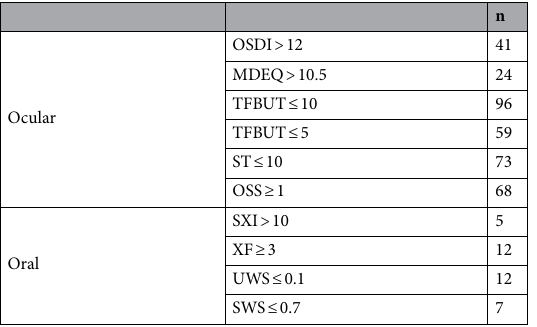
Table 3. Number of subjects with pathological levels of ocular and oral variables. OSDI ocular surface disease index, MDEQ McMonnies Dry Eye Questionnaire, TFBUT tear film break-up time, ST Schirmer I Test (mm/5 min), OSS ocular surface staining, SXI summated xerostomia inventory, XF xerostomia frequency, UWS unstimulated whole saliva (mL/min), SWS stimulated whole saliva (mL/min).